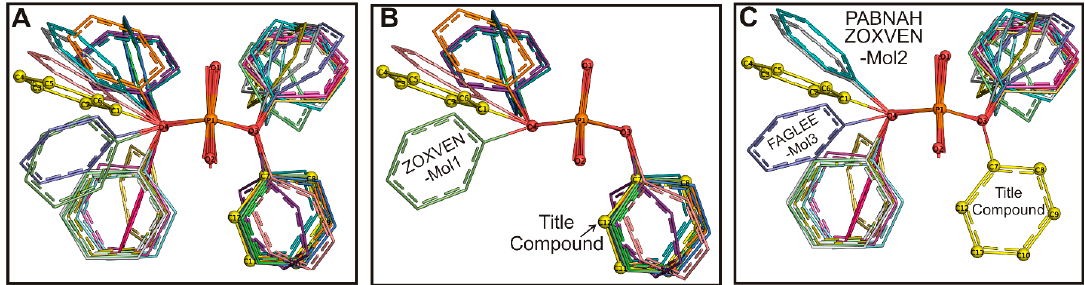
Figure 8. Structural comparison of diphenyl phosphate moiety of the title compound with the literature. ( A ) Superposition of diphenyl phosphate moieties extracted from the CSD with the title compound. The title compound is shown in yellow (carbon atoms), ball-and-stick model. Based on the torsional angle C7–O3–P1–O4, two major conformational flexibilities − sc and +sc were observed. The models representing − sc group are shown in ( B ), and the models that adopt +sc are shown in ( C ). The deviating models in both groups are